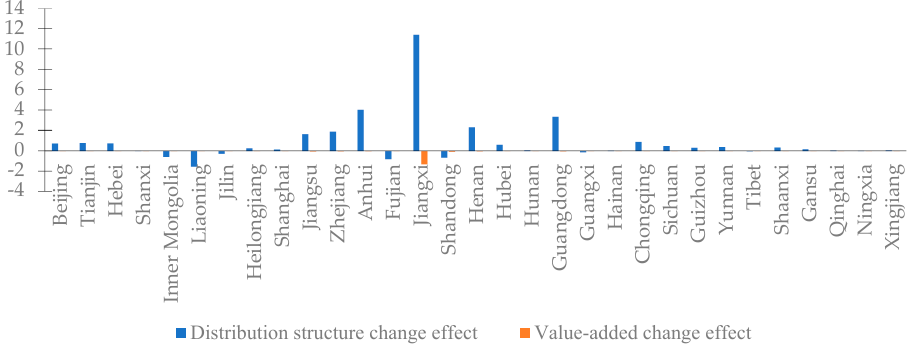
Figure 6. Distribution structure change effect and value-added change effect of various regions in China (unit: CNY 100 million).